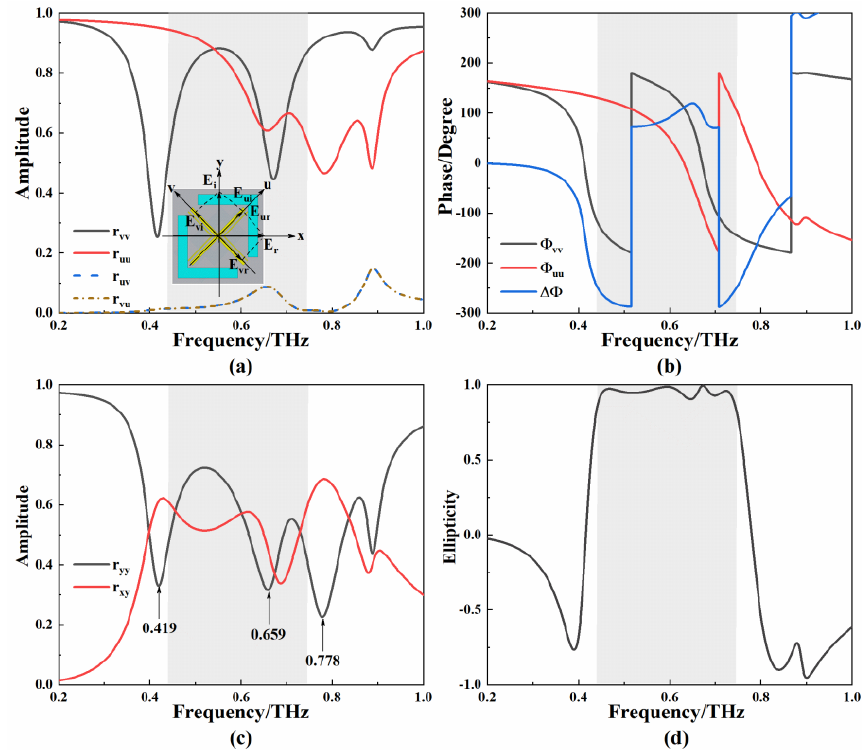
Figure 6. ( a ) Schematic diagram and simulation curve of the I-side metamaterial in u – v coordinate system; ( b ) phase difference of simulation curve of the I-side metamaterial in u – v coordinate system; ( c ) simulation curve of the I-side metamaterial in x – y coordinate system; ( d ) calculated ellipticity.